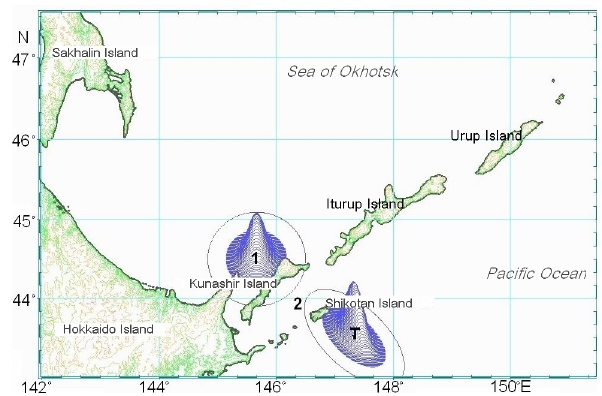
Fig. 1. A map showing the region of the South Kuril Islands and a scheme of numerical experiments. Symbols 1, 2 and T indicate the epicenters of the sources. Initial sea surface elevations at Source 1 and Source T are